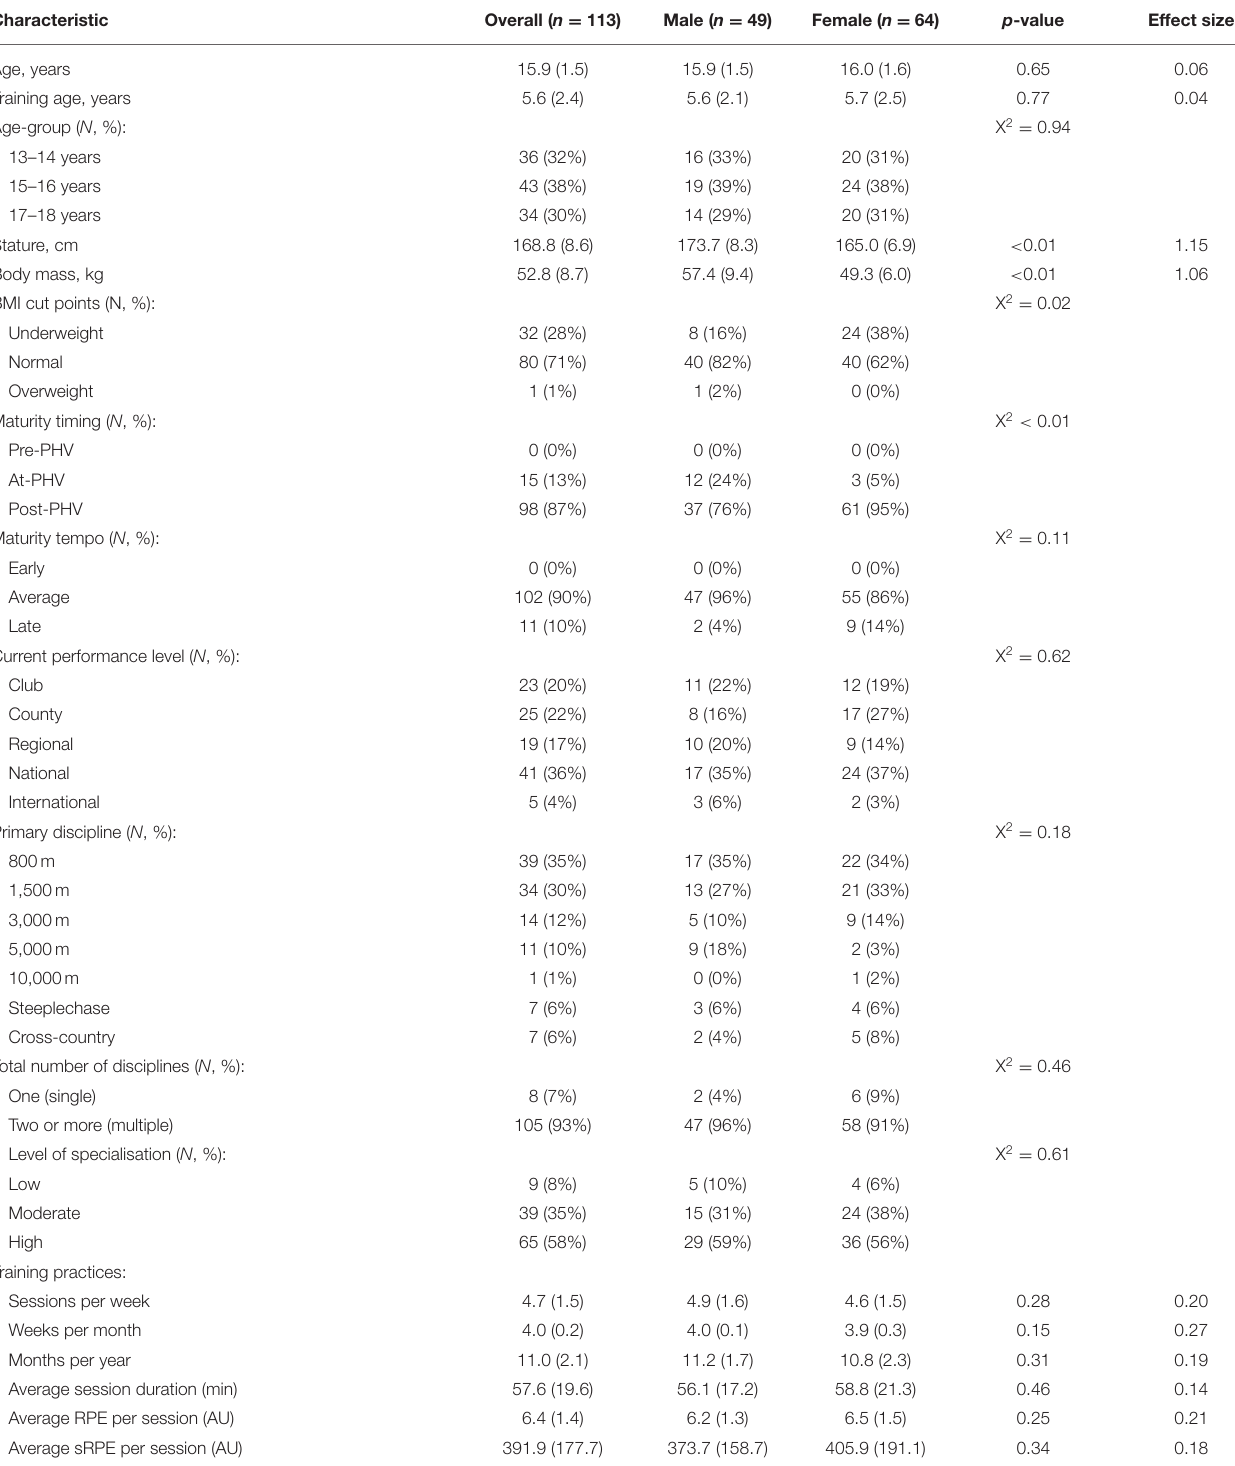
TABLE 1 | Descriptive characteristics of the participants (data presented as mean and SD, unless otherwise stated). Characteristic Overall ( n =